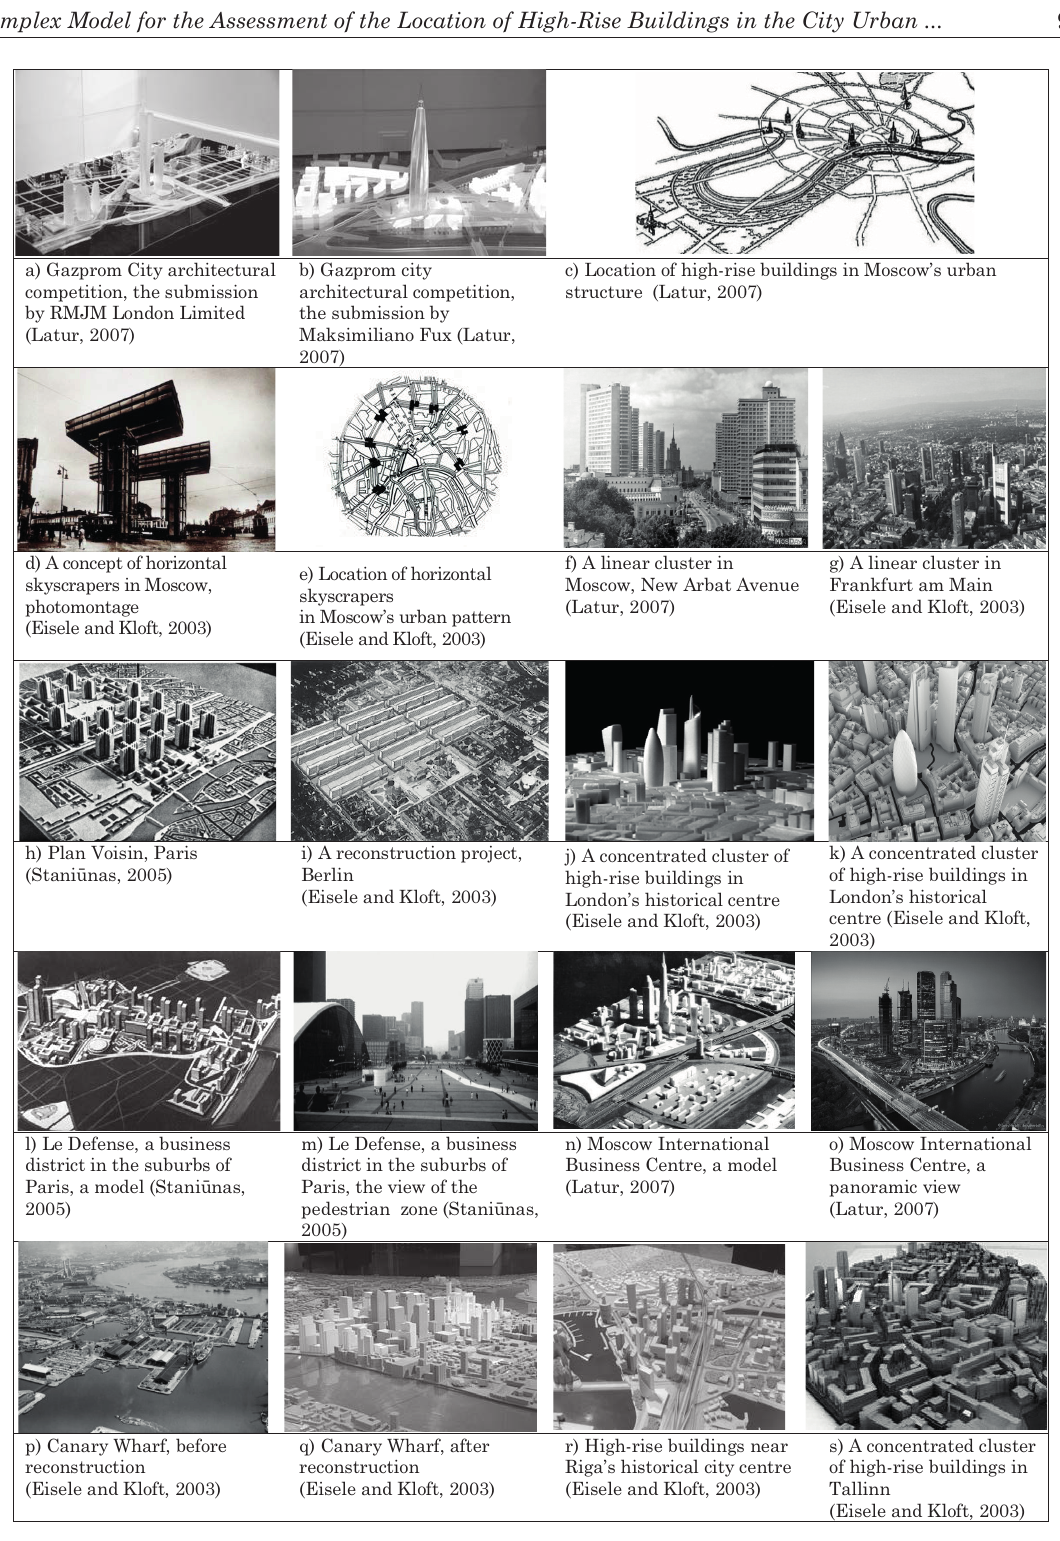
figure 1. Some examples of location models for high-rise buildings in european